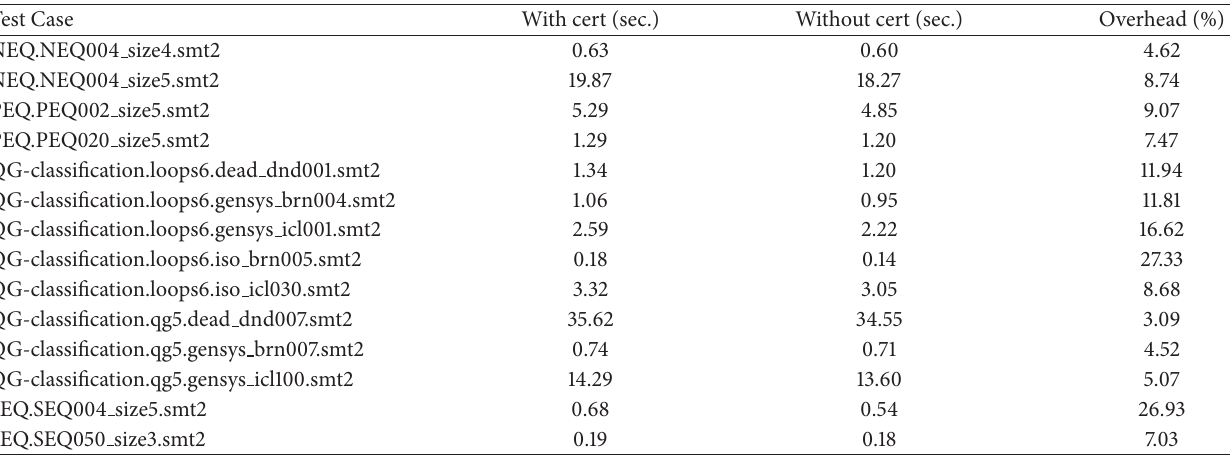
Table 5: Overhead of our approach.